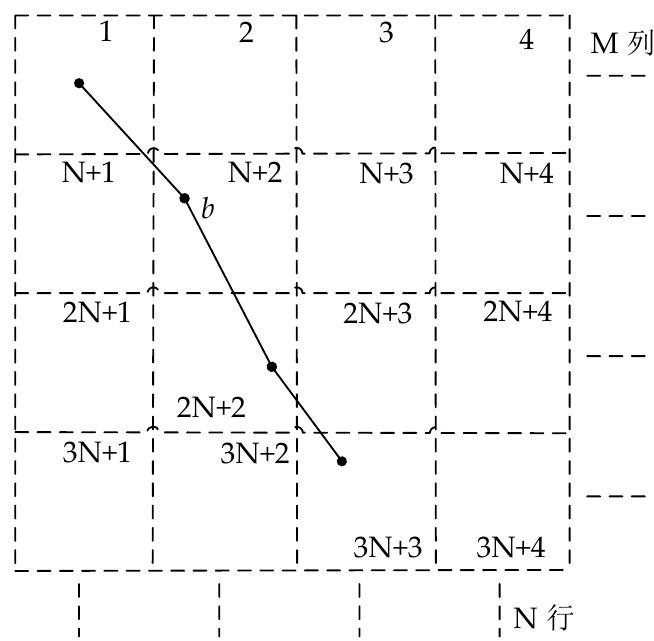
Figure 15. The diagram of spatial grid indexes (the grid index numbers covered by stroke b are 1, N + 1, N + 2, 2N + 2, 2N + 3, and 3N + 3).